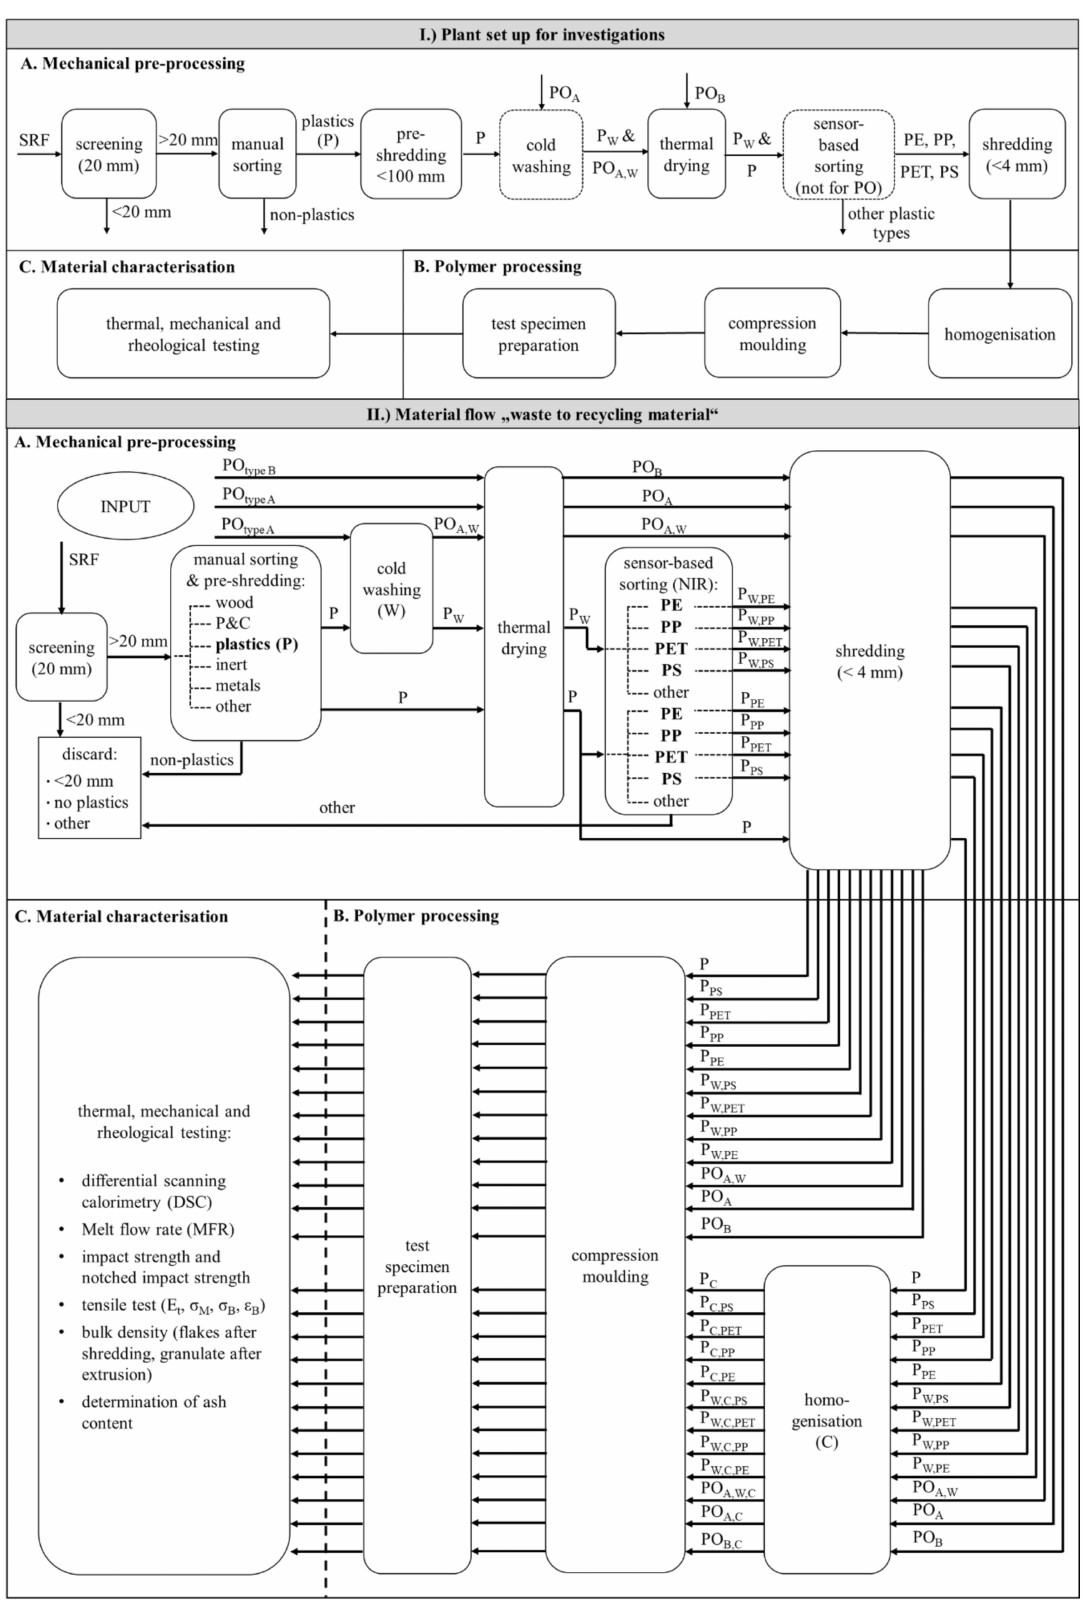
Figure 1. Flow chart for the plant set up of the investigations ( I ) and all material flows of input materials and resulting flows during the investigations ( II ); The process is divided into three sub-processes: A . Mechanical pre-processing, B . Polymer processing and C . Material